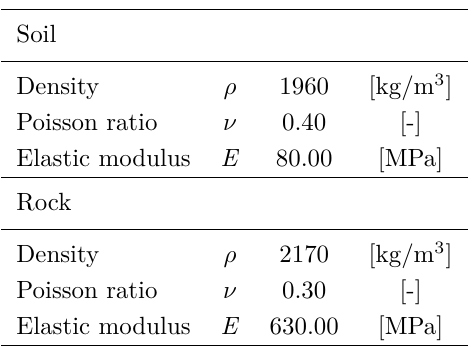
Table 1. Material